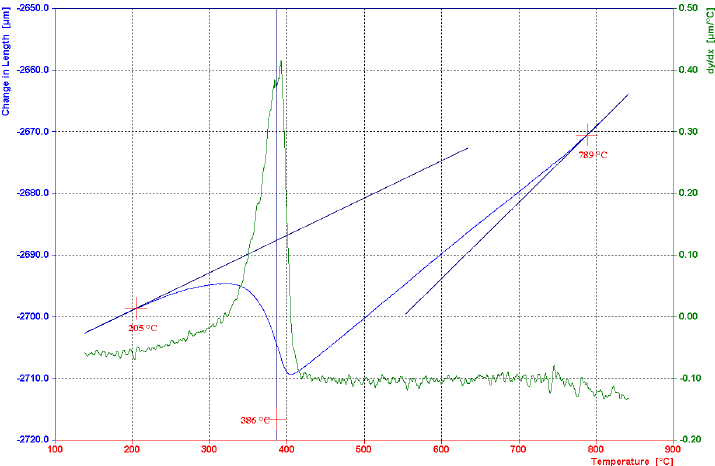
Figure 9. Dilatometric curve registered during cooling of 3 Mn steel at a rate of 1 °C/s.